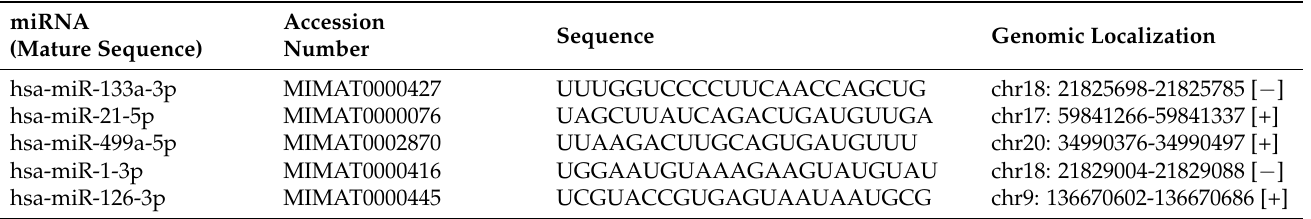
Table 1. Summary of the main information of the tested miRNAs, the accession number inserted into this tool, the sequence of the mature miRNA, and the genomic localization.